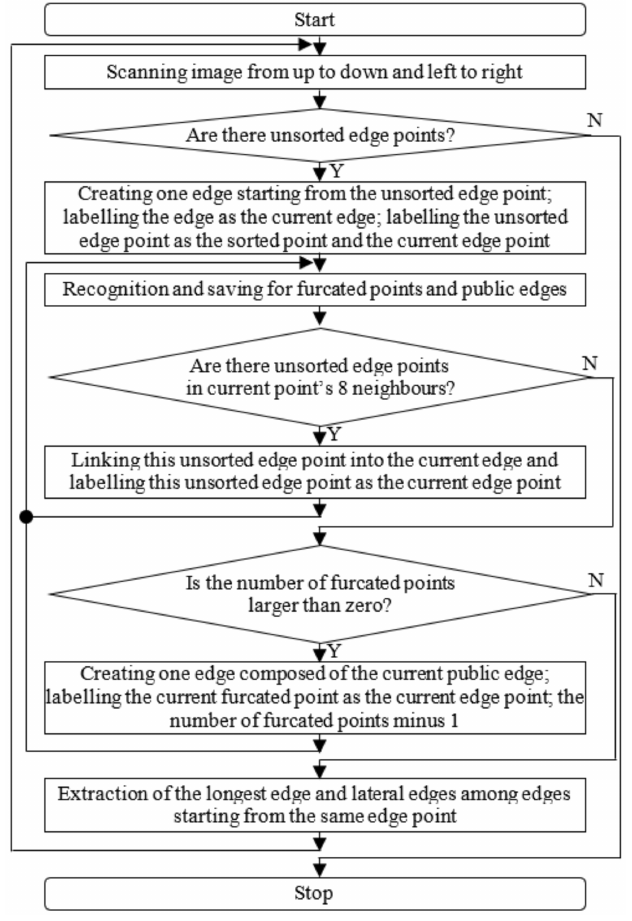
Figure 4. Flowchart of edge sorting algorithm. Edge type